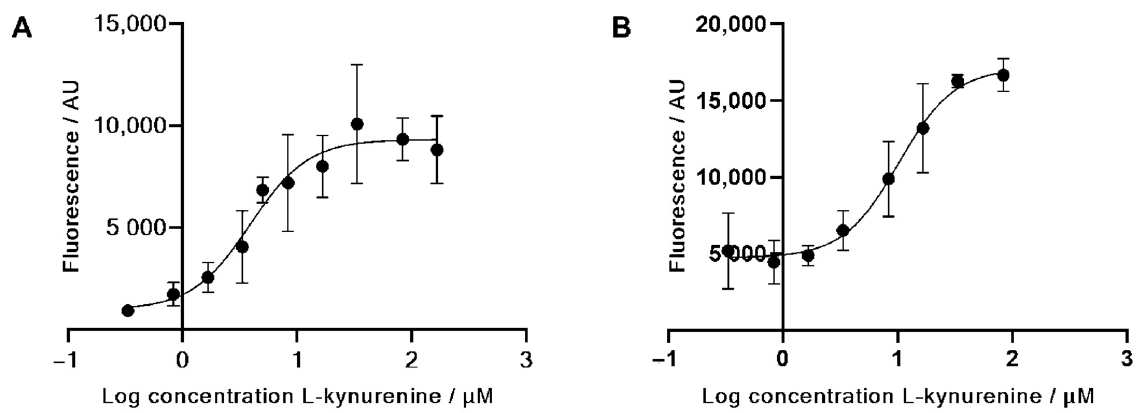
Figure 4. Competitive antibody binding assay in magnetic bead assay of the L-kynurenine–rhodamine B conjugate 5 against native L-kynurenine in ( A ) PBS and ( B ) artificial saliva. Fluorescence of the solution increases with increasing L-kynurenine concentration, meaning native kynurenine competes in antibody binding against the kynurenine conjugate.